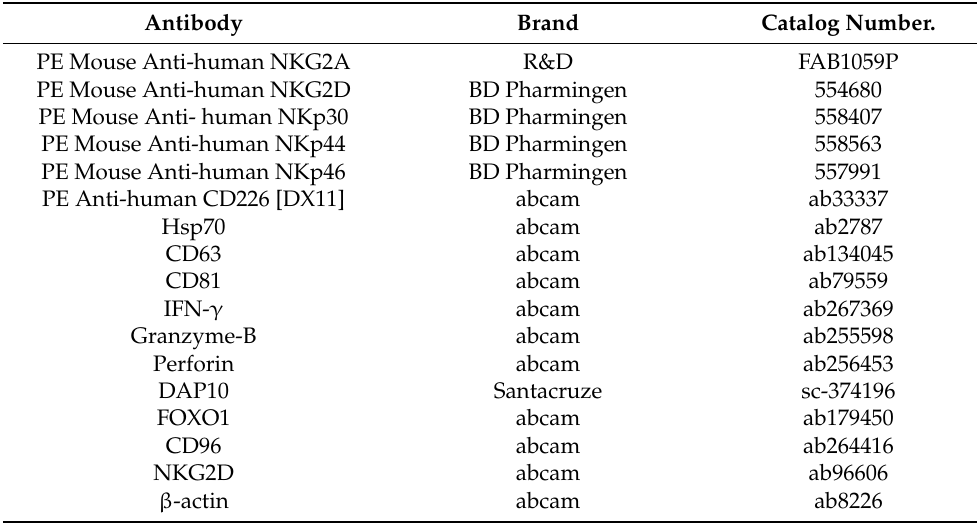
Table 1. The information of all